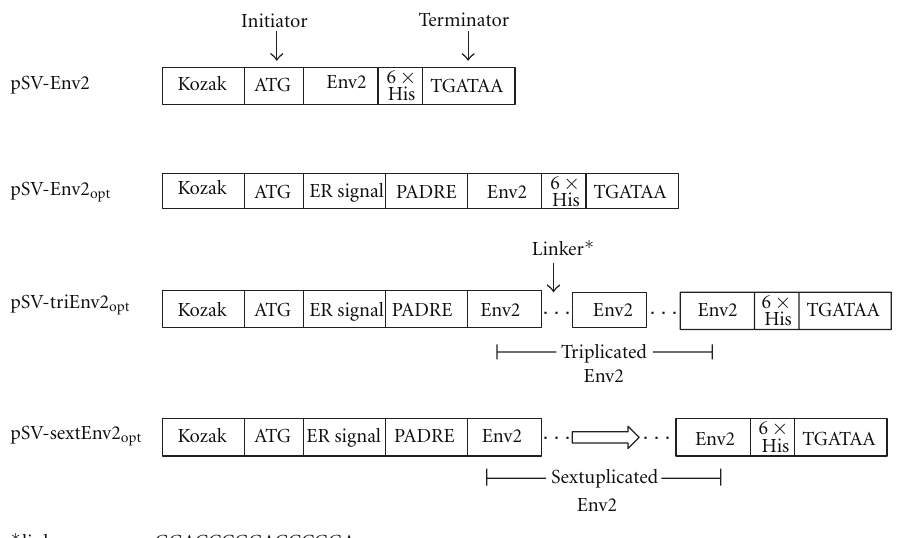
Figure 1: The diagram of epitope-based DNA vaccine design. To construct pSV-Env2 opt , pSV-triEnv2 opt , and pSV-sextEnv2 opt , a Kozak sequence, an ER signal sequence, and a universal Th2 epitope (Pan DR epitope, PADRE) were introduced into the 5 (cid:3) end of each epitope encoding gene and a 6 × His-tag was added at the 3 (cid:3) end. A linker sequence was also inserted between adjacent epitopes. pSV-Env2 was constructed without adding ER signal sequence nor